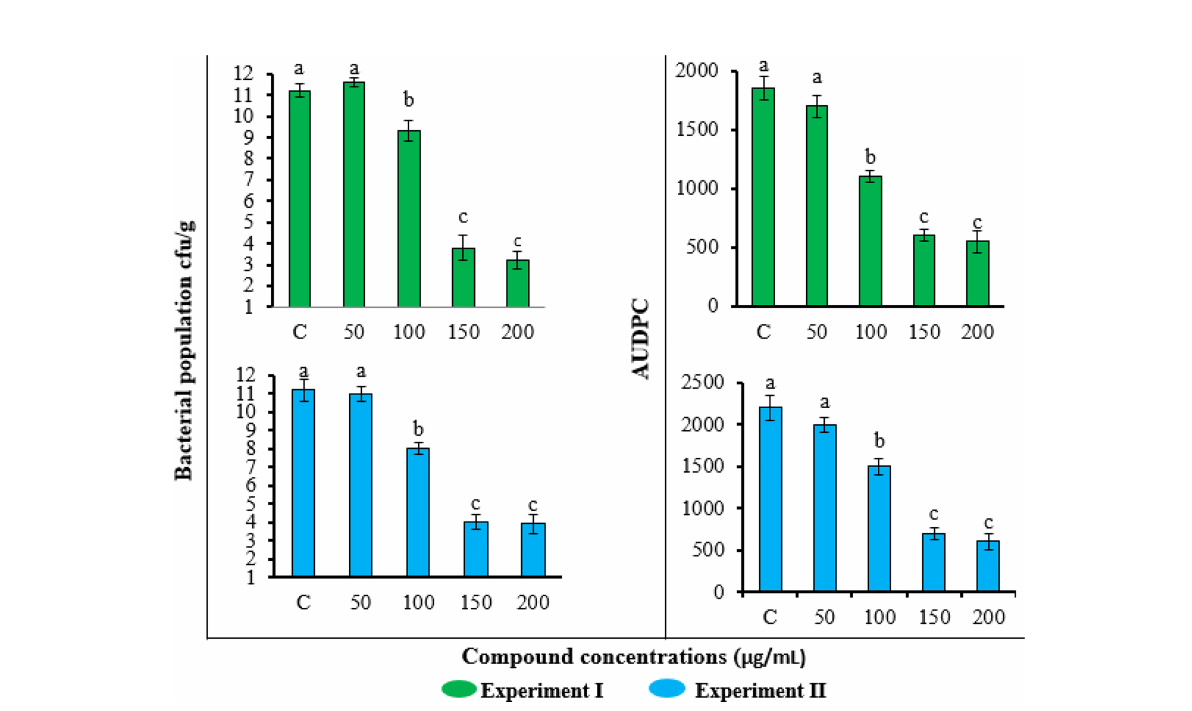
FIGURE 5 Effect of different concentrations of furoic acid on Ralstonia solanacearum population in soil and disease severity area under the disease progress curve value in pot experiment. C, control plants without any treatment. Bars represent the standard error. Lower case lettering shows the signi fi cant difference among the treatments.